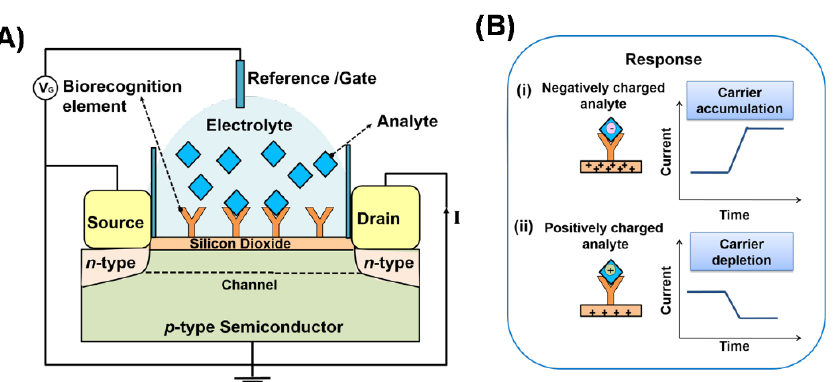
Figure 7. ( A ) Field-effect transistor (FET)-based biosensor with a p -type semiconductor channel. ( B ) ( i ) Negatively charged target molecules captured by the biorecognition elements accumulate positive charge carriers (holes) in the channel, which increases the current from the source to the drain electrode. ( ii ) If positively charged target molecules bind with the biorecognition elements, the holes are depleted and the current decreases.